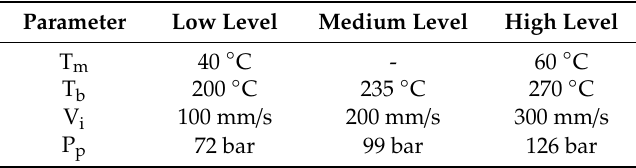
Table 1. Table 1. Machine-settings for the moulding